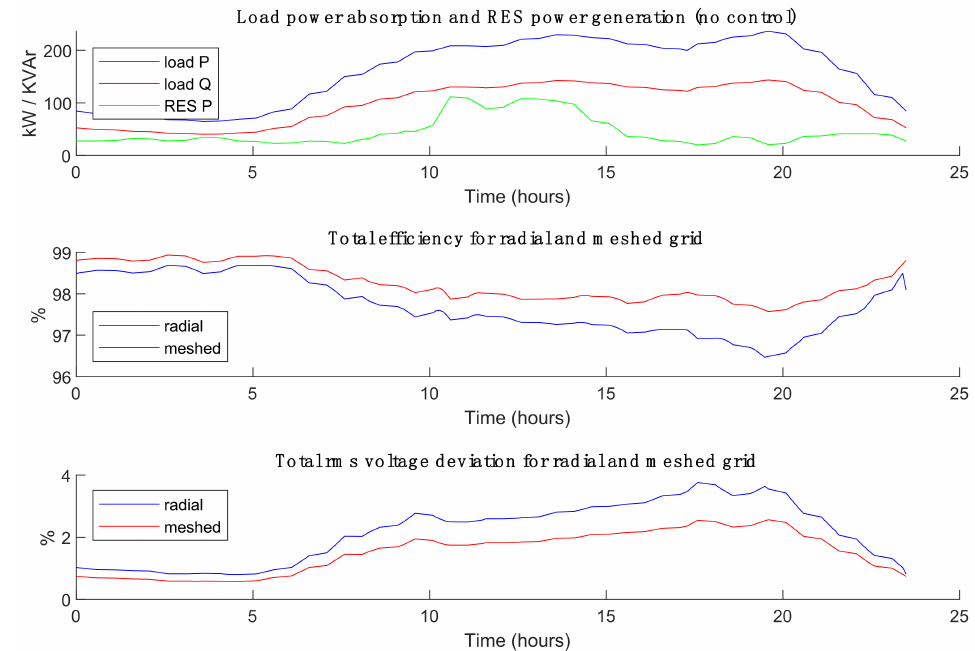
Figure 5. Comparison of quality indexes for radial and meshed